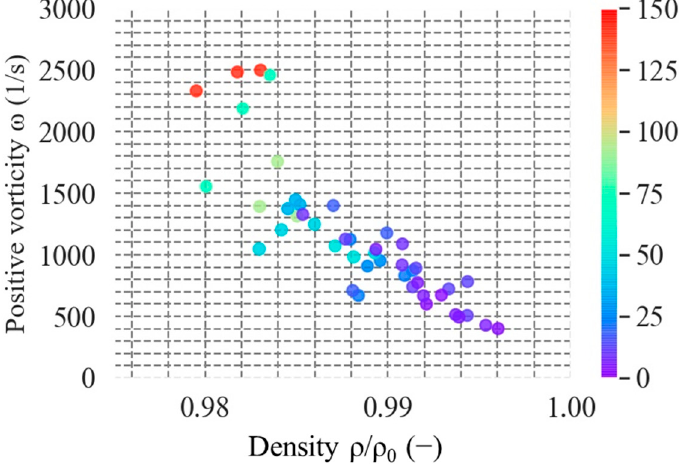
Figure 13. Comparison of positive vorticity and